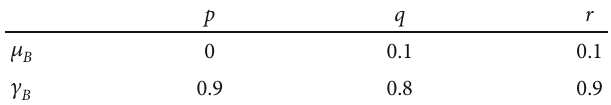
Table 26: Intuitionistic fuzzy set B